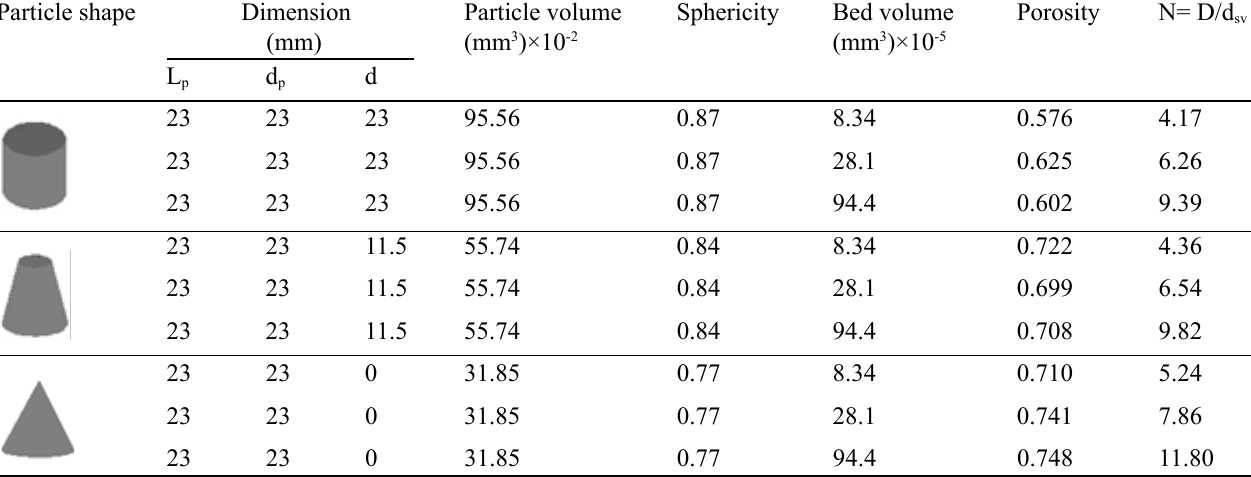
Table 4. Characteristics of particles and